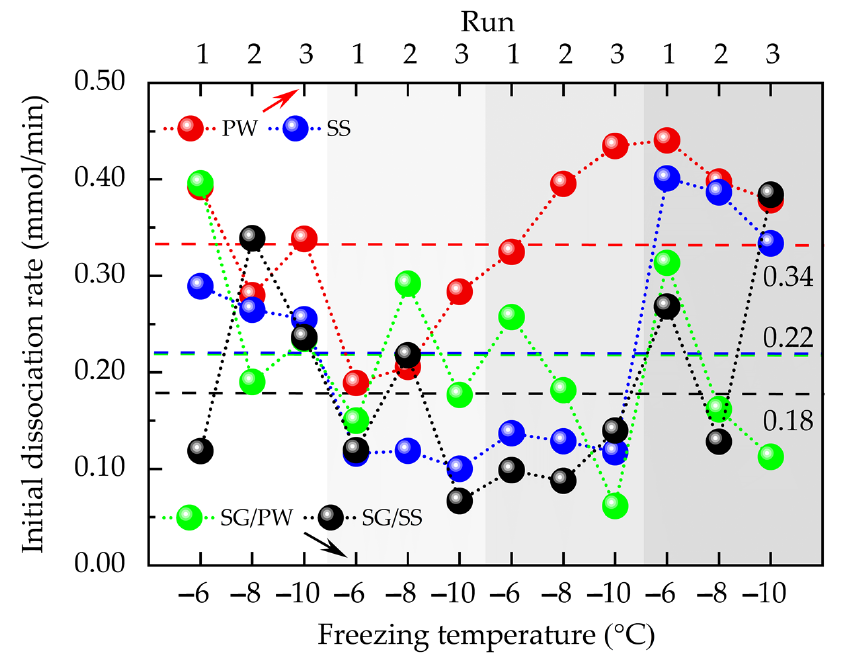
Figure 7. Measured initial dissociation rates (IDR) as the self-preservation effect of the hydrates were removed in different runs. The meanings of the four backgrounds in the figure are the same as those in Figure 6.